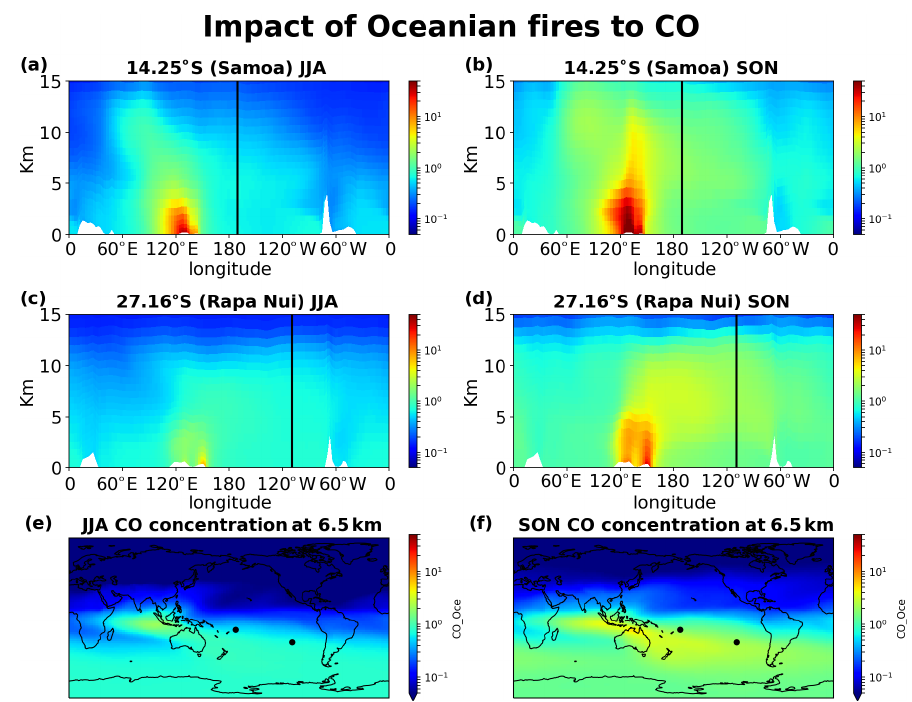
Figure 15. Impact of Oceanian fires on CO concentrations. (a) JJA and (b) SON 20-year mean impact at the cross section of Samoa, (c) JJA and (d) SON at the cross section of Rapa Nui, and (e) JJA and (f) SON horizontal distribution of the contribution at 6.5km altitude.